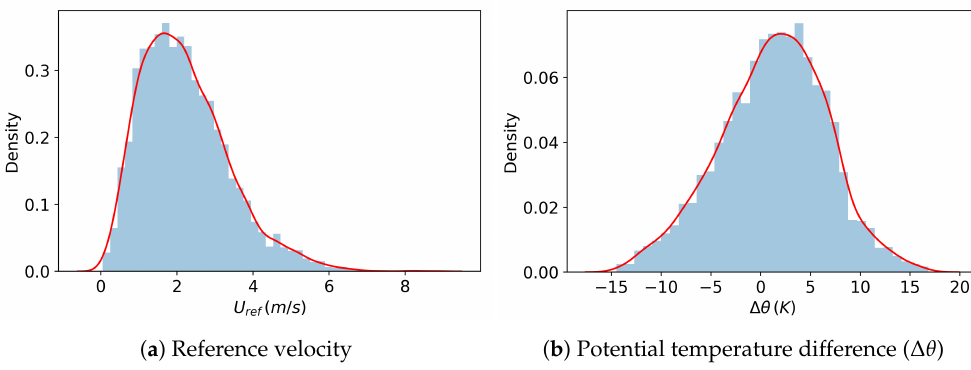
Figure 4. Distribution of bulk Richardson number in BASEL.